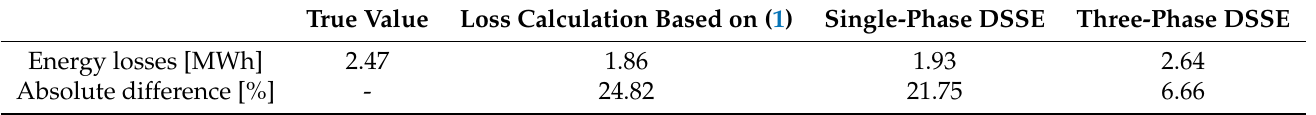
Figure 8. Plot of ( a ) Estimated active power loss, ( b ) errors in estimated active power loss, and ( c ) active power supplied from substation transformer. Table 2. Comparison of active energy loss estimation for 1